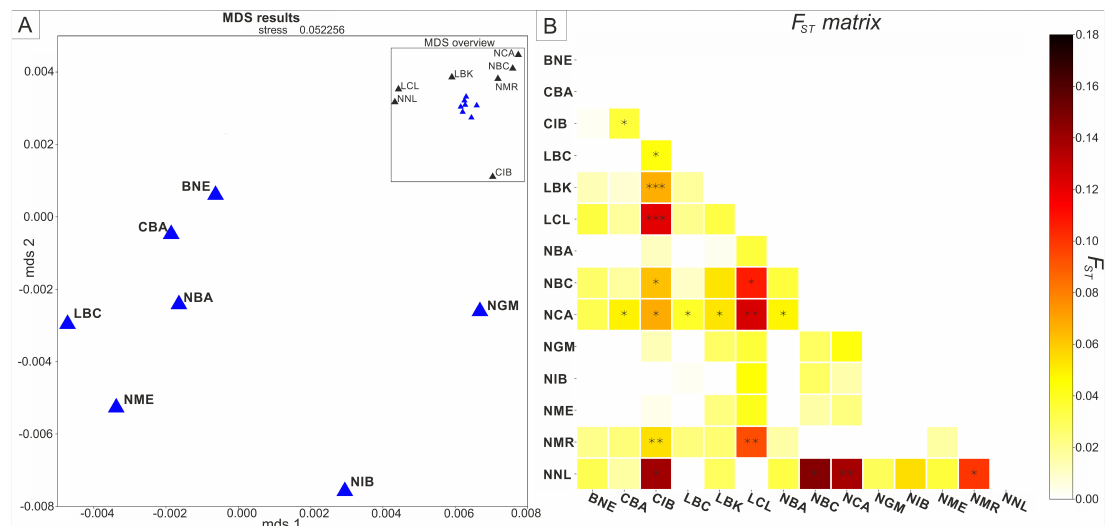
Figure 3. ( A ) Multidimensional scaling (MDS) plot of pairwise genetic distances (F ST ) values obtained for complete mitochondrial genomes, ( B ) Matrix of F ST values, defined by color, statistical significance p < 0.05 (*), p < 0.005 (**), p < 0.0005 (***). (BNE) Bronze Age Near East, (CBA) Chalcolithic Balkans, (LBC) Late Bronze Age Caucasus, (LCL) Late Chalcolithic Levant, (MIC) Minoan Create, (NBA) Neolithic Balkans, (NBC) Neolithic to Bronze Age Caucasus, (NCA) Neolithic Central Anatolia, (NGM) Neolithic Greece and Macedonia, (NME) Neolithic Middle East, (NMR) Neolithic Marmara Region, (NNL) Natufian and Neolithic Levant, (CIB) Chalcolithic Iberia, (NIB) Neolithic Iberia, (LBK) Linear Pottery